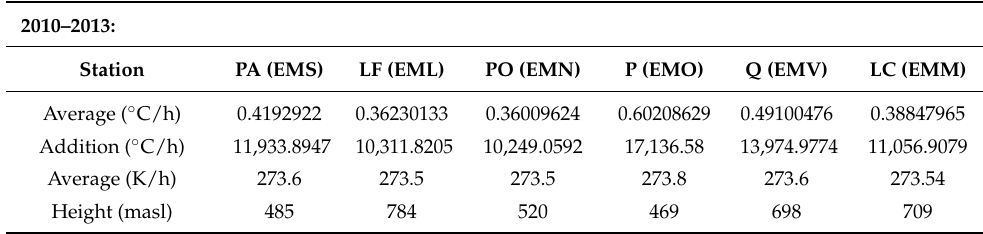
Table 3. For the period 2010–2013, in all the measurement locations, the average of and the height with respect to sea level are